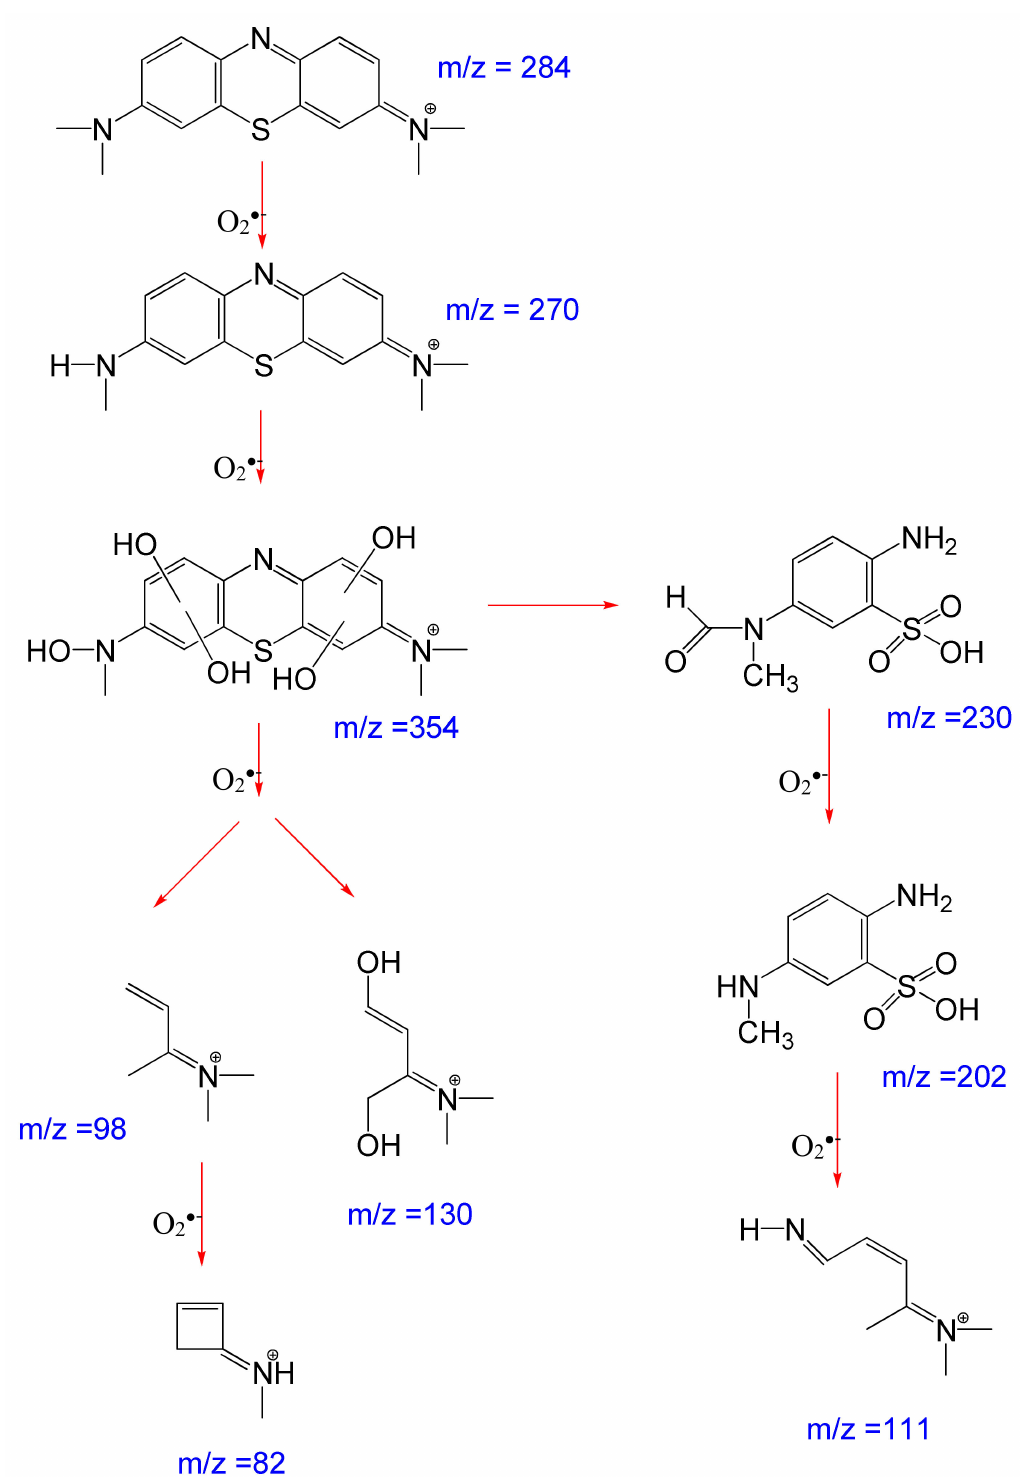
Figure 8. Degradation pathway of methylthioninium chloride (MC + ) by Ag/AgCl-G under